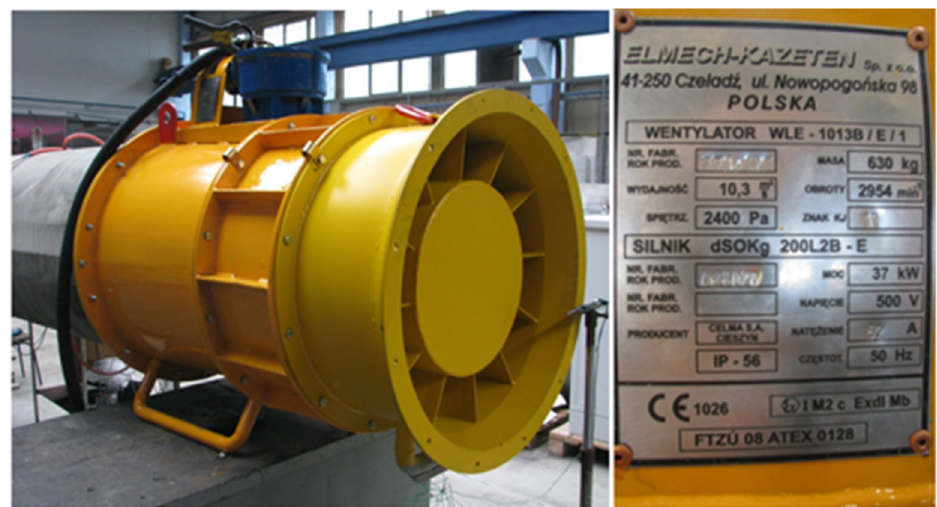
Figure 2. Electric axial fan ELMECH-WLE-1013B/E/1 [12]. Table 1. Input data for the blade design process . Lp.